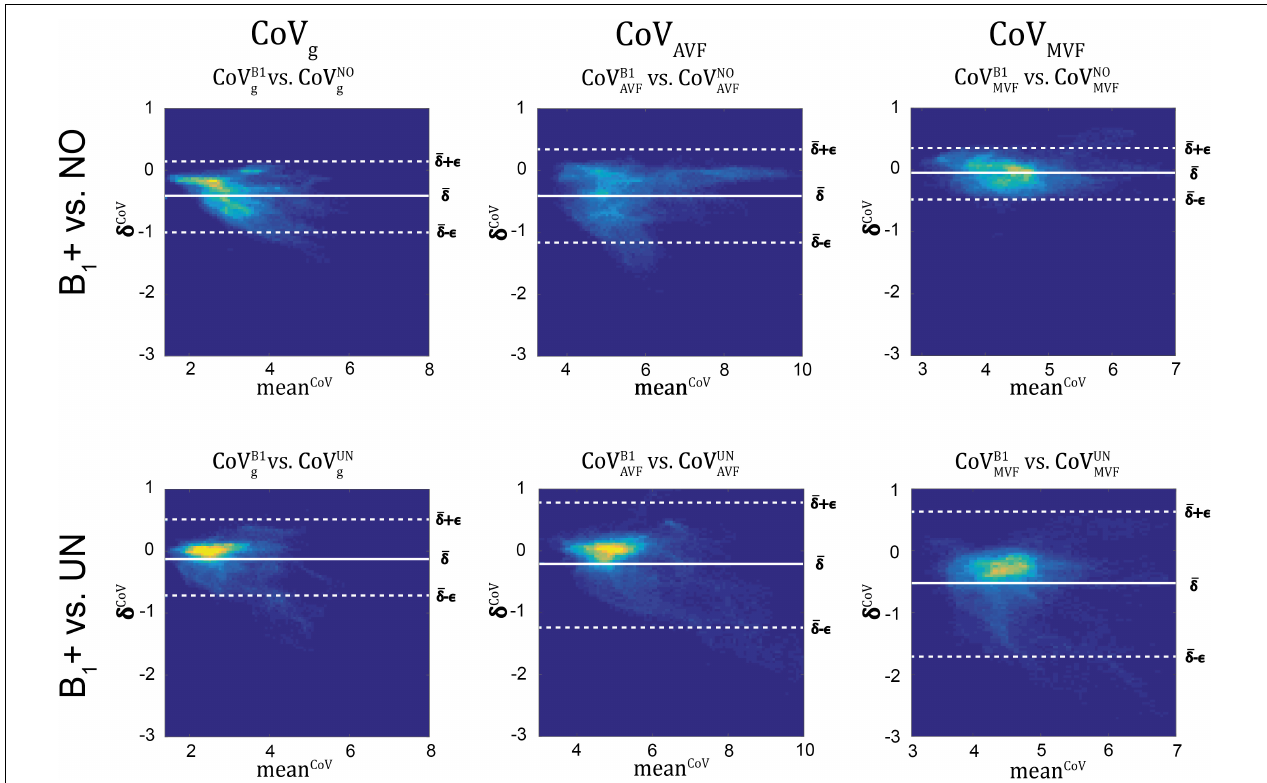
FIGURE 11 | Bland-Altman density plots of CoV g , CoV AVF , and CoV MVF for no correction (NO, top row) and UNICORT B 1 + correction (UN, bottom row) against the reference method (B 1 +) (yellow indicates high density and blue low). The Bland-Altman plot depicts the differences between the tested parameter maps and the reference method (e.g., δ CoV